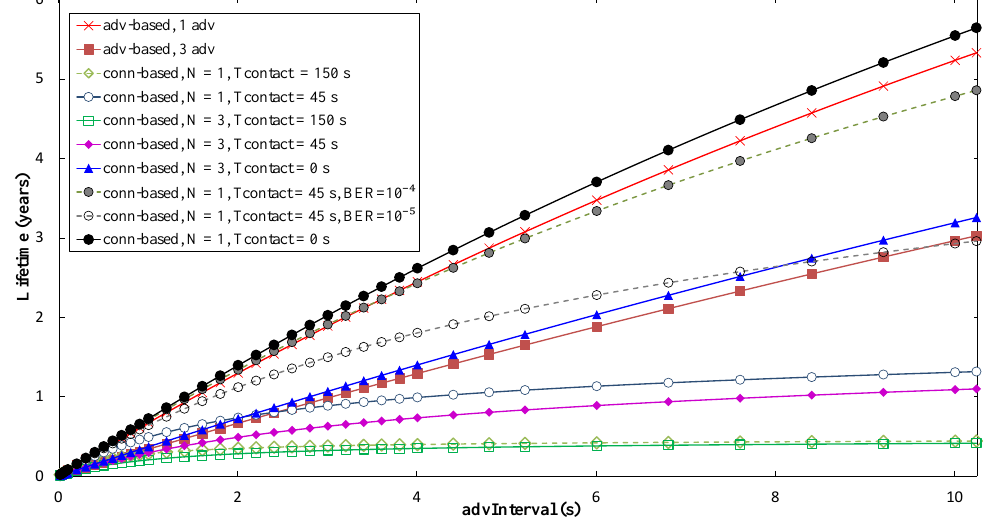
Figure 17. Average sensor node lifetime, for the advertisement-based and connection-based approaches, as a function of advInterval , and for different N , T contact and BER values, and assuming a time between contacts of one day. For connection-based results, connInterval = 4 s has been assumed.